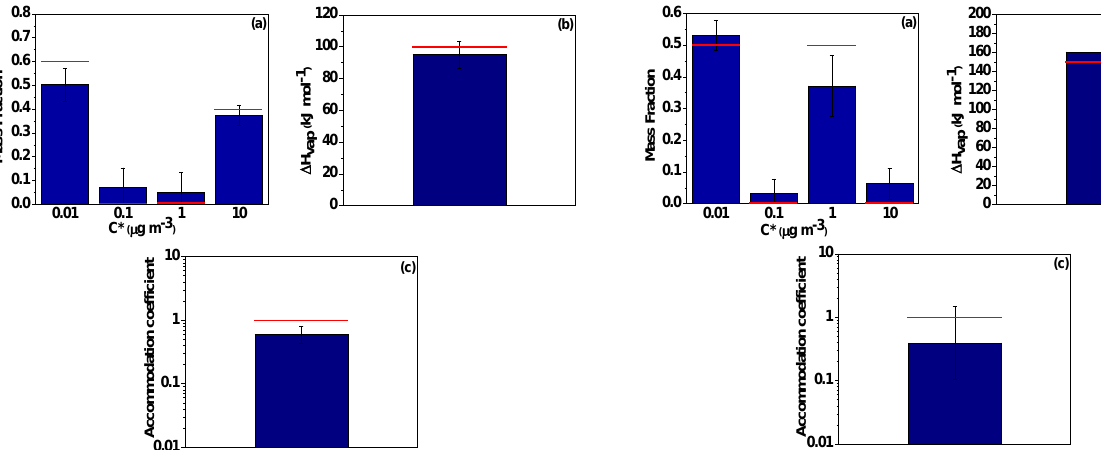
Figure 9. Estimated (bars) and true (red lines) parameter values combining TD and isothermal dilution measurements, for an OA with 50% 0.01 μg m -3 and 50% 1 μg m -3 , ΔH vap =150 kJ mol -1 and a m =1 for: (a) volatility distribution, (b) ΔΗ vap , (c) a m .